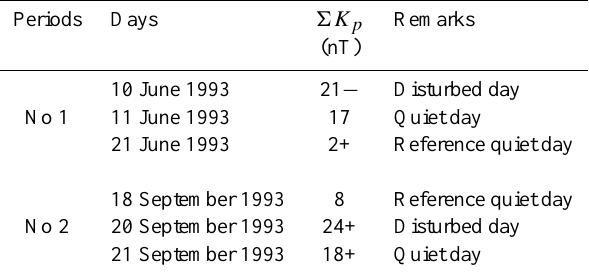
Table 1. Geophysical context of the periods of